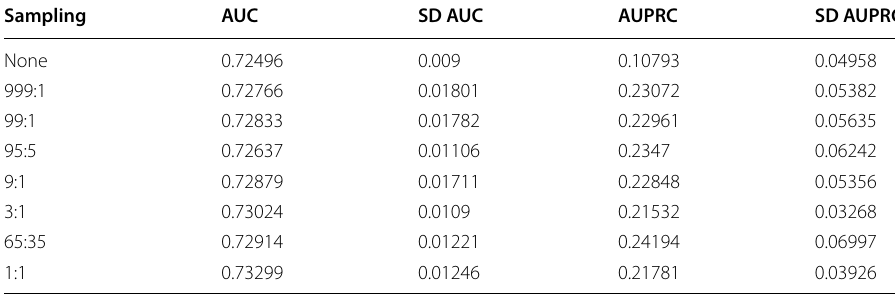
Table 12 Results for Naive Bayes